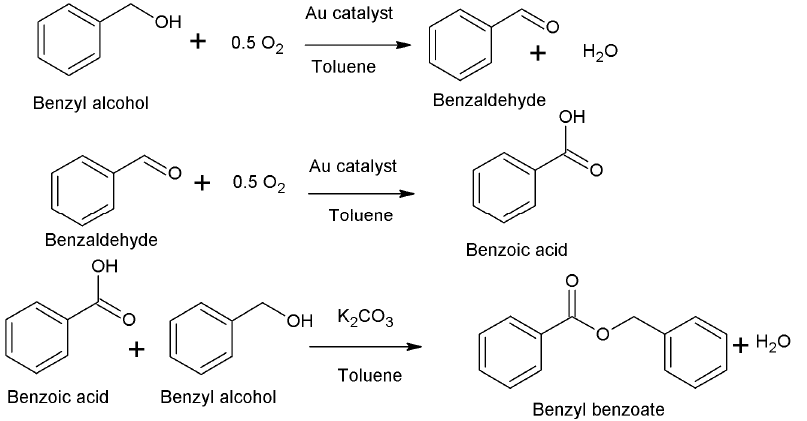
Figure 8. Benzyl alcohol oxidation pathways.